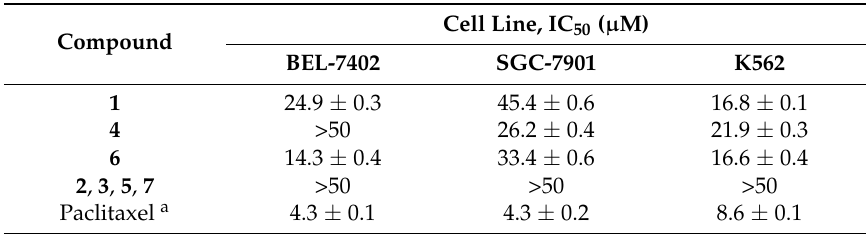
Table 3. Cytotoxicity of compounds 1 – 7 in the human cancer cell lines.